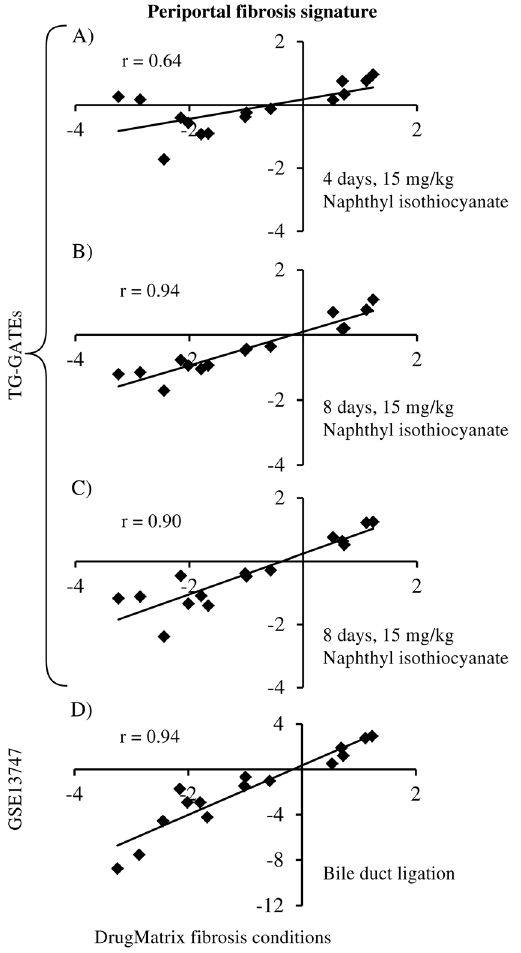
Figure 11. Analysis of exposures in GSE5509 using the general liver injury gene signature. Multidimensional scaling (MDS) plot of six chemical exposures in GSE5509 using the general liver injury gene signature. This figure shows the ability of the genes in the general liver injury signature to separate toxicants from non-toxicants. Rosiglitazone, caerulin, and di-nitro phenol, the non-toxic compounds in this set are marked in green circles. a -Naphthyl-isothiocyanate, dimethyl nitrosa- mine, and N-methyl formamide are the toxic compounds in this set, and they are marked with red triangles. In the MDS plot, the non-toxic compounds clustered separately form the toxic compounds. We have highlighted the non-toxic compounds within a green circle.